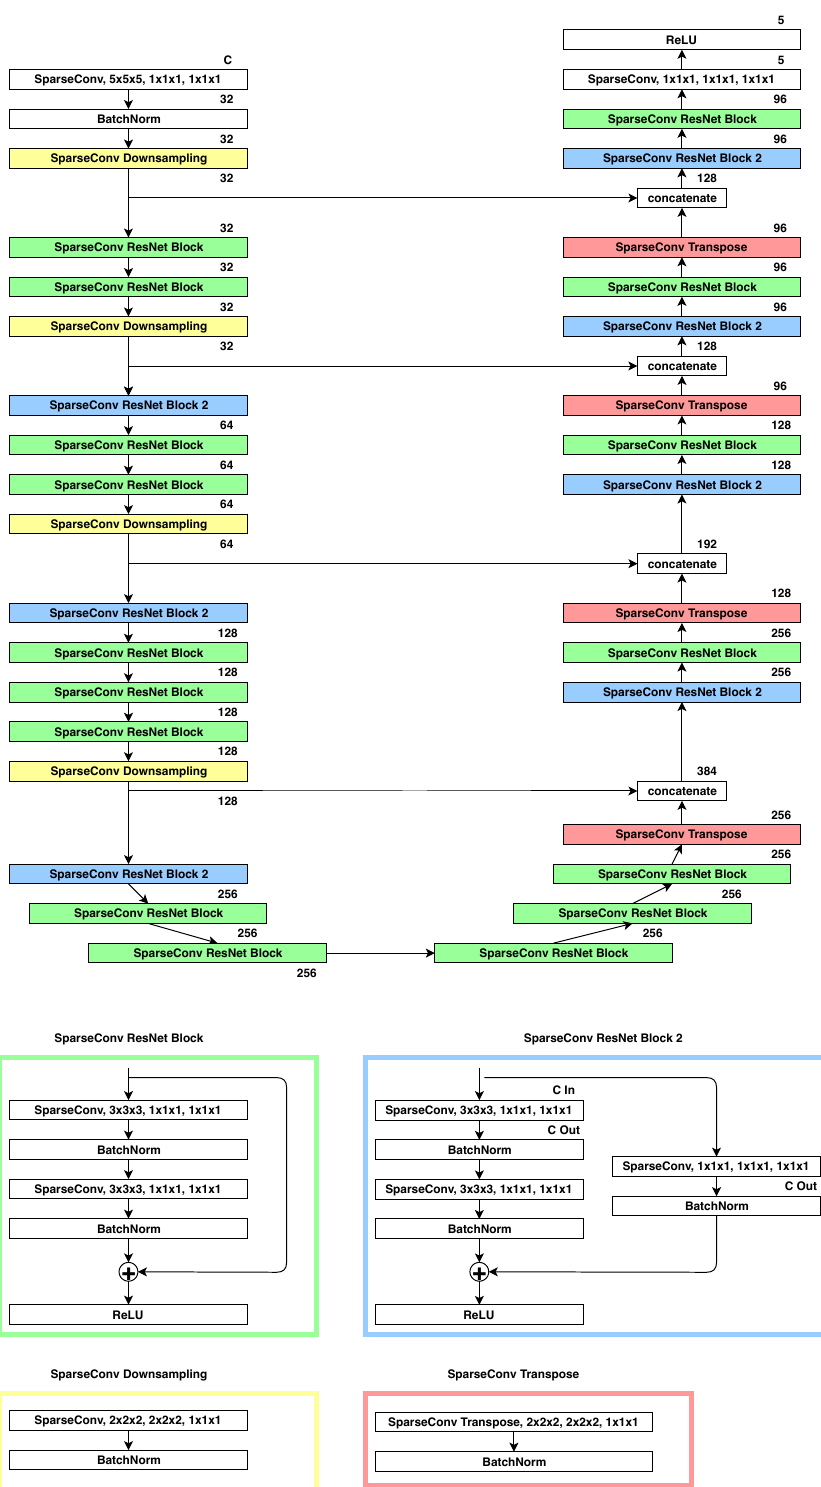
Figure 6. The network architecture used for semantic segmentation of the derived point cloud from tri-stereo satellite images. From its basic structure, it is a U-Net with its encoder and decoder paths, and the skip connections between the two. Further, it incorporates residual learning from Res-Nets in the sparse convolutional blocks and batch